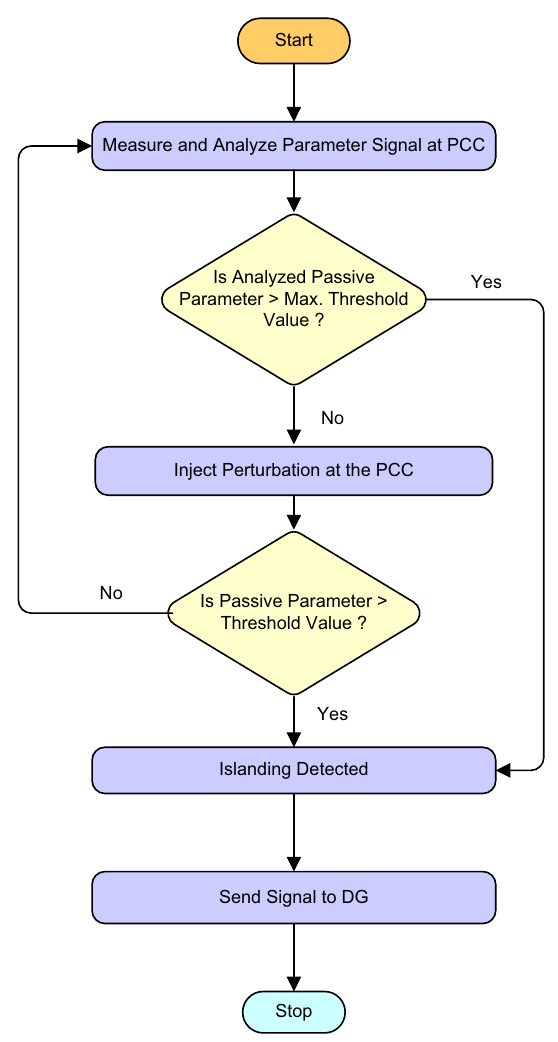
Fig. 6 Algorithm for hybrid islanding detection